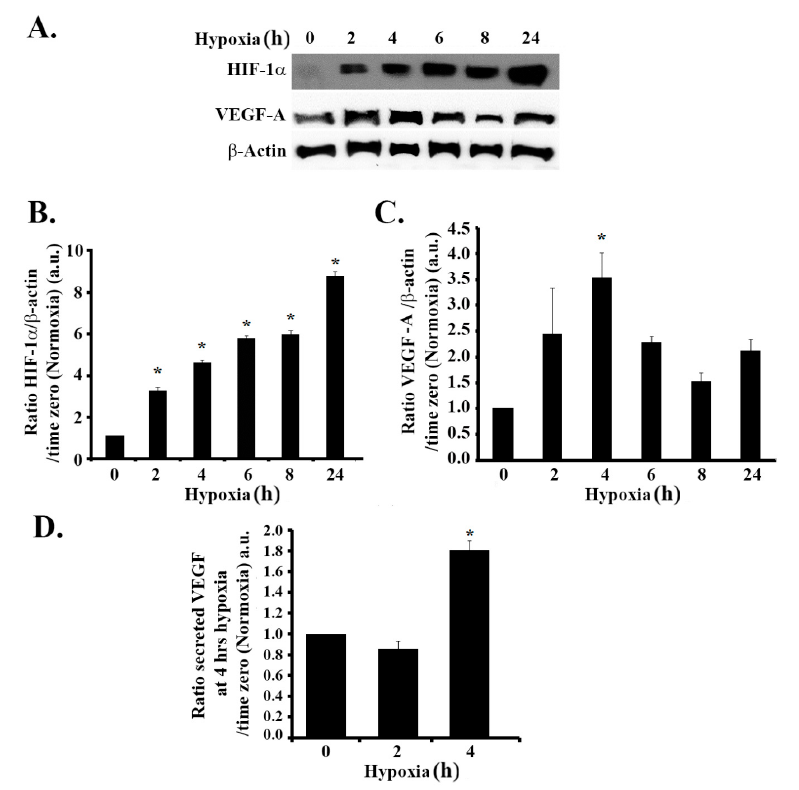
Figure 1. Hypoxia mimicking increases the expression of hypoxia-inducible factor (HIF-1a) and the expression and secretion of vascular endothelial growth factor (VEGF) in glioblastoma cells. ( A ) SF-268 cells subjected to hypoxia using cobalt(II) chloride hexahydrate (CoCl 2 ) up to 24 h. The total cell lysates were collected at different time intervals (2, 4, 6, 8, and 24 h post hypoxia or normoxia), as indicated, and the samples were blotted against HIF-1 α , VEGF-A, or β -actin antibodies. Quantitation of HIF-1 α ( B ) or VEGF-A ( C ) using ImageJ. The bands were normalized to β - actin and expressed as fold change compared to the control (normoxia). ( D ) SF-268 cells were subjected to hypoxia using cobalt(II) chloride hexahydrate (CoCl 2 ) for 2 or 4 h or left in normoxic conditions. The supernatant was collected and measured for VEGF-A secretion (compared to standards) according to the manufacturer’s guidelines (described in Section 2). The data are means ± standard error of the mean (SEM) from three different experiments ( n = 3); * p < 0.05 indicates statistically significant differences.